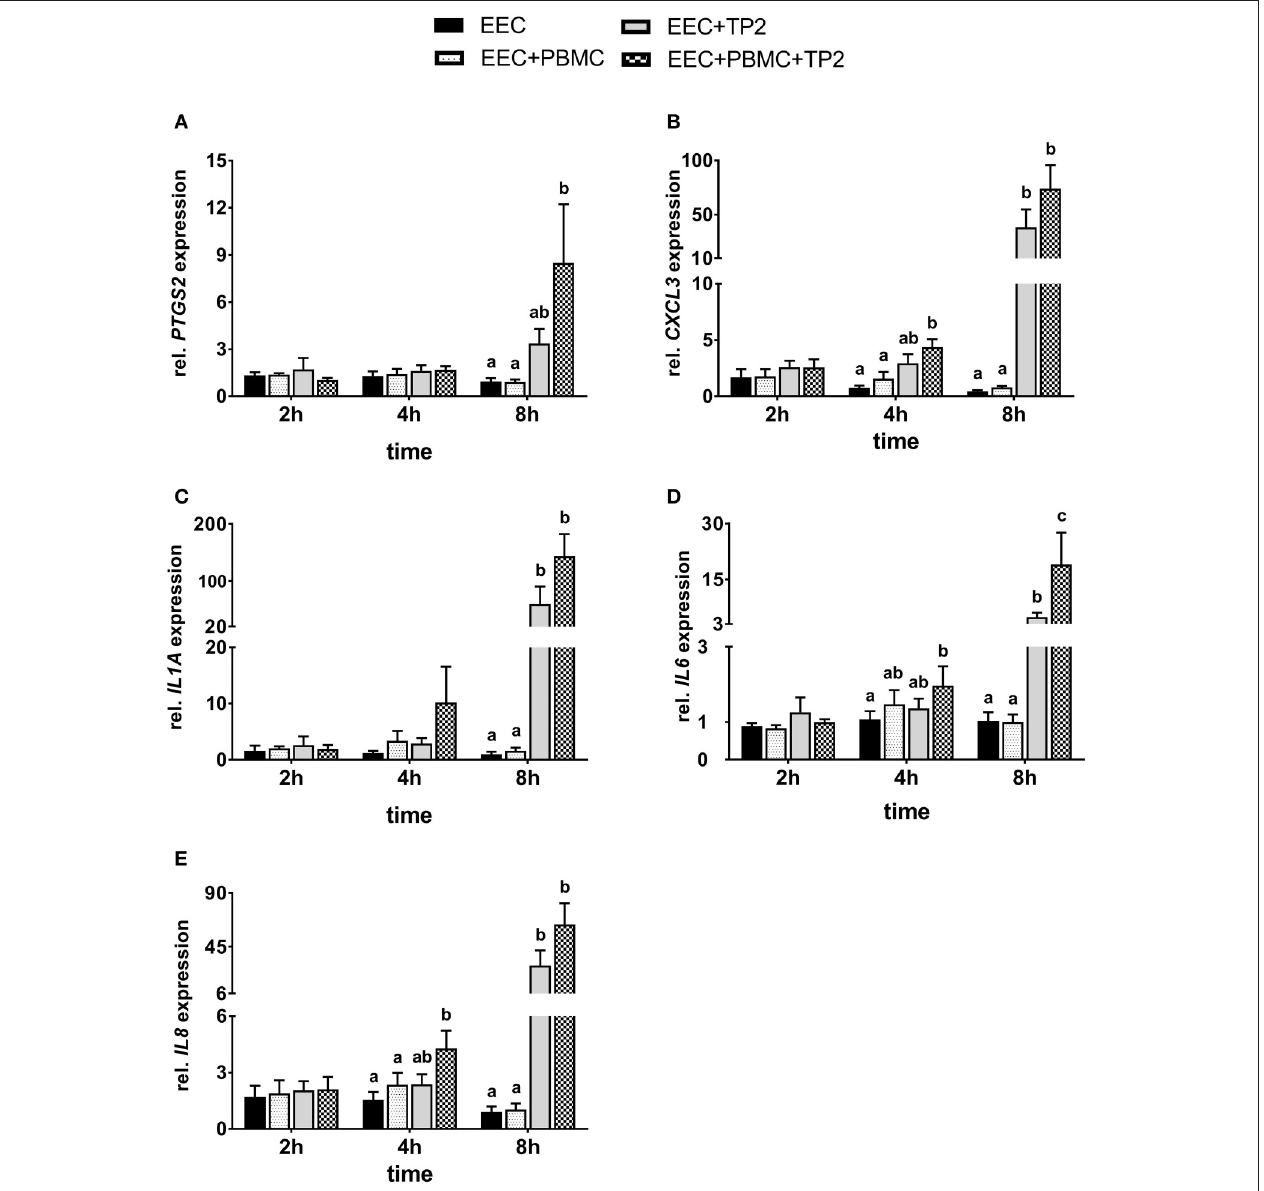
FIGURE 6 | Relative mRNA expression of (A) PTGS2 , (B) CXCL3 , (C) IL1A, (D) IL6 , and (E) IL8 in bovine endometrial epithelial cells co-cultured with PBMC at a ratio of 1:1 and/or live TP2 at MOI = 1 up to 8 h. The bars show means ± SEM of mRNA expression values from different cultures ( n = 5 cows). Different small letters (a,b,c) above the bars indicate significantly different mRNA expression between different treatments ( P < 0.05).